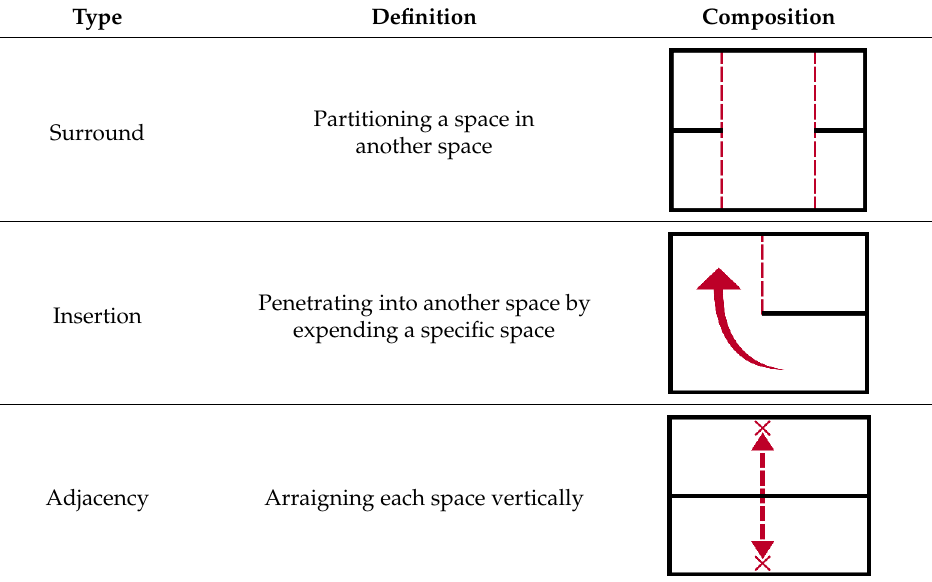
Table 1. Types of vertical space connections.